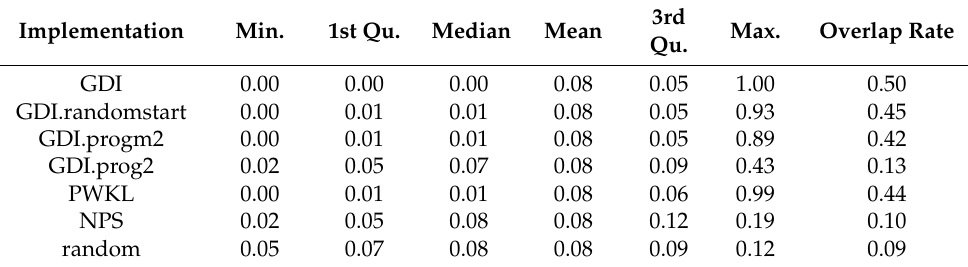
Table 2. Item exposure comparison for the seven fixed-length CD-CAT implementations. Implementation Min. 1st Qu.